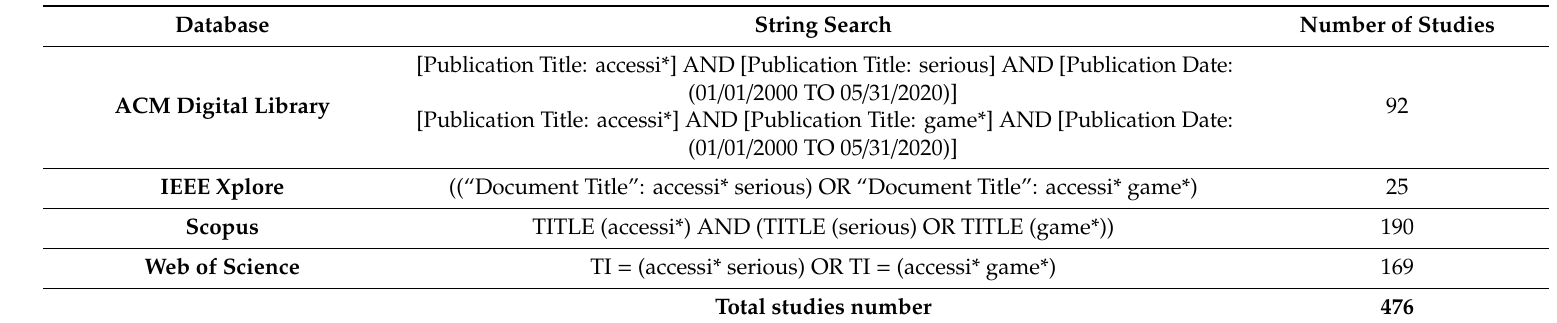
Table 1. Query string applied.